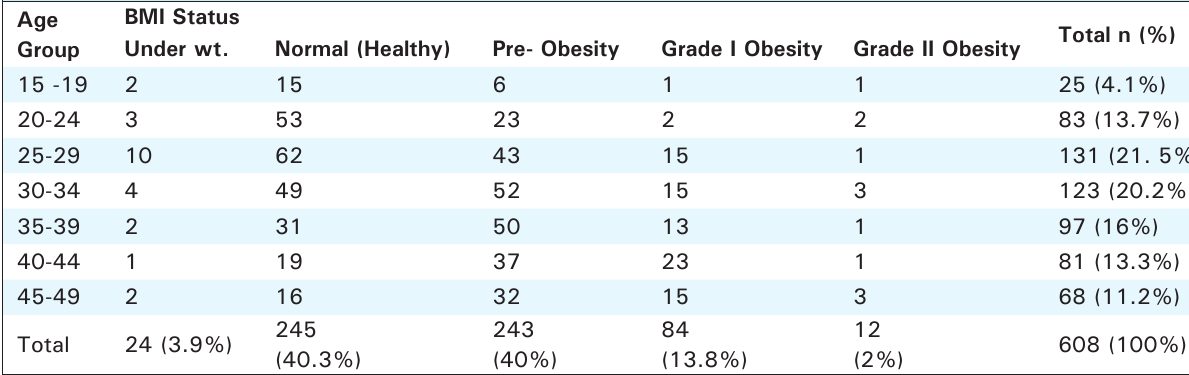
Table 1. Age wise distribution of BMI status in 2017.